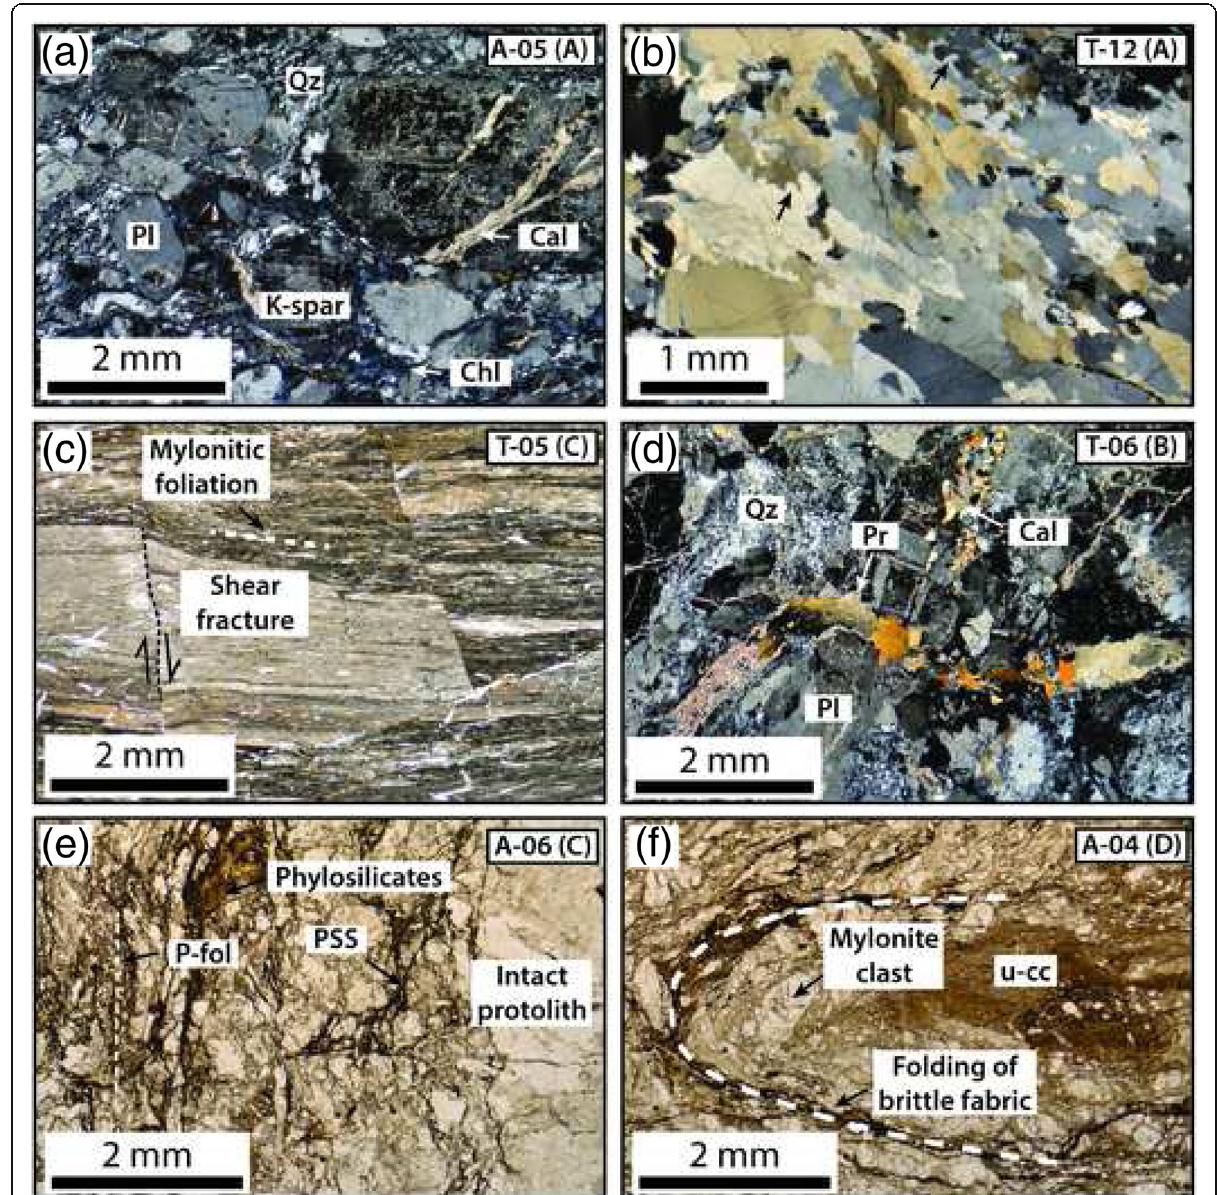
Fig. 5 Ryoke-derived fault rocks in thin section. Letter after sample name indicates the degree of cataclasis (see text). a Lightly fractured Ryoke protomylonite sample containing altered plagioclase (Pl) and K-feldspar (K-spar) porphyroclasts wrapped by a matrix of recrystallised quartz (Qz) and chlorite (Chl). Fractures within feldspar porphyroclasts are filled with calcite (Cal) (cross-polarised light). b Exterior mylonite sample showing characteristic coarse recrystallised quartz grains, separated by lobate grain boundaries (arrows; cross-polarised light)). c Ultramylonite sample that has undergone limited fragmentation and slip along shear fractures (plane-polarised light). d Protomylonite sample cut by late-stage coarse- grained prehnite (Pr) – calcite veins (cross-polarised light). e Cataclasite displaying progressive granulation and development of a phyllosilicate foliation (P-fol) from right to left. PSS pressure-solution seam (plane-polarised light). f Cataclasite displaying isoclinal folding of a cataclastic foliation, with ultra-cataclasite (u-cc) developed in the fold hinge (plane-polarised